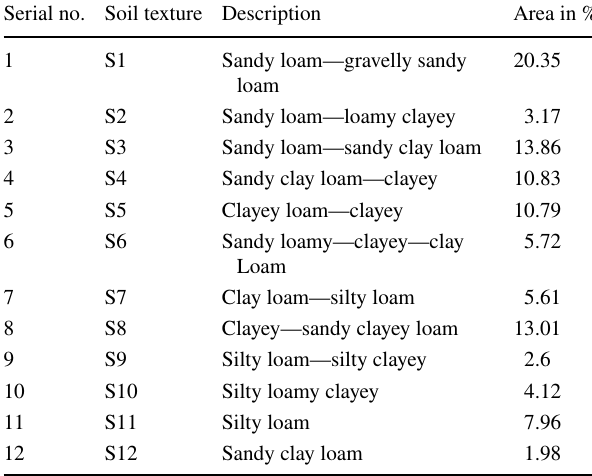
Table 3 Details of soil texture with the percentage of area Serial no. Soil texture Description